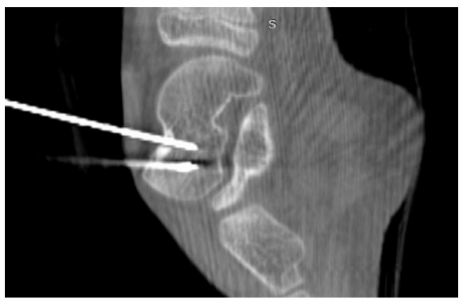
Figure 18. Intraoperative photograph during thermoablation with 3D navigation.